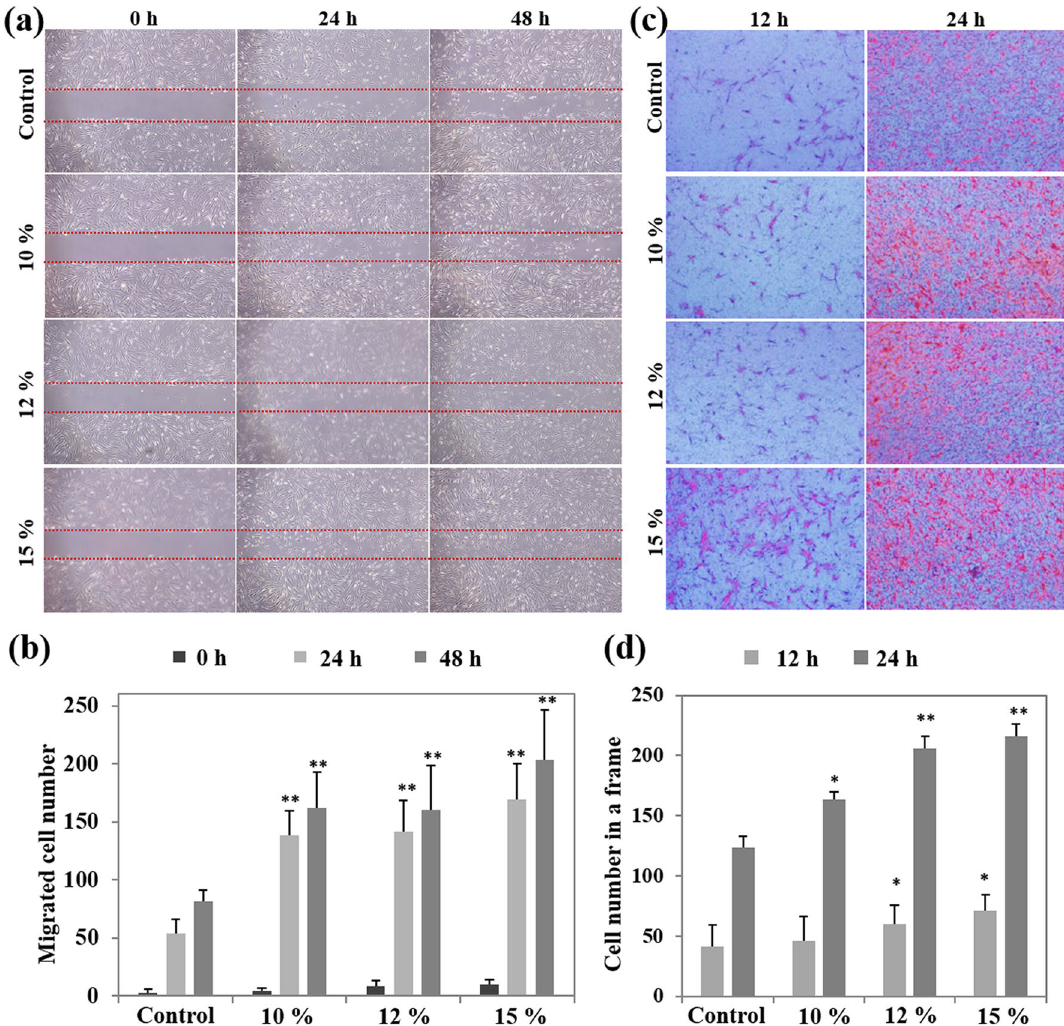
Figure 2. ( a ) In vitro scratch assay. Optical microscopy images were taken at 0, 24, or 48 h after treatment with 10, 12, or 15% ultrasound for 10 s. Dashed lines indicate the scratch. Control cells were treated with medium alone. ( b ) The numbers of migrated fibroblasts were quantified by direct cell counting. ** P < 0.01 compared with cell numbers at the same time in the control group. ( c ) Transwell migration assay. Fibroblasts that had migrated through the Transwell filters were fixed at 12 or 24 h after treatment with 10, 12, or 15% ultrasound for 10 s, and stained with hematoxylin. The representative images were taken under optical microscopy. ( d ) The numbers of fibroblasts in a frame were counted. * P < 0.05, ** P < 0.01 compared with the cell numbers at the same time in the control group. All statistical analysis methods were one-way lagen type I. Given that fibronectin interacts with specific domains on the fibroblast surfaces and is involved in several cellular activities such as cell adhesion, growth, migration and differentiation 31,32 , upregulated fibronec- tin expression may directly increase fibroblast proliferation and migration following HIUS treatment, and vice versa. Once fibroblasts accumulate in the wound site via migration or proliferation, they deposit collagen matri- ces required for granulation. Therefore, the activation of fibroblasts by HIUS treatment may be an efficient strat- egy to accelerate wound healing. Gene expression profiling. To understand the molecular mechanism underlying HIUS-induced fibro- blast activation and upregulated expression of extracellular matrix components such as fibronectin and col- lagen, we examined the gene expression profile of HIUS-treated fibroblasts using RNA-sequencing. Compared with non-treated control cells, 41 and 111 genes were upregulated and downregulated, respectively, in response to HIUS (Fig. 4a, Tables S1 and S2). Based on gene set enrichment analysis using DAVID for differentially- expressed genes 27 , biological processes such as the MAPK cascade, cytokine production, and cell proliferation and migration were upregulated, whereas transcription-related and stress or inflammatory response-related pathways were downregulated (Fig. 4b). Of the upregulated processes, MAPK pathways mediate various cel- lular responses to diverse external stimuli, including mitogens and stresses, and therefore play an important